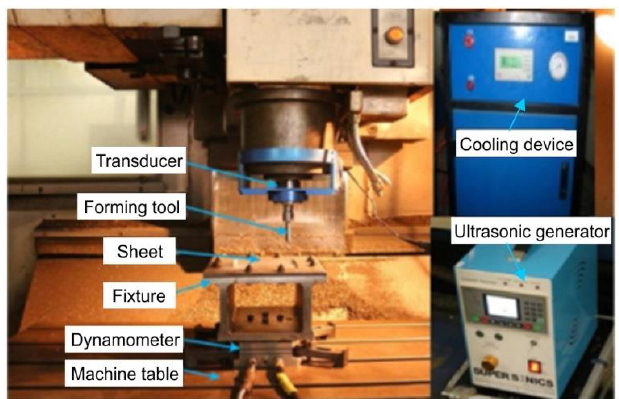
Figure 8. The experimental configuration of the UISF process (adapted with permission from Ref. [75], 2019, copyright the Authors).